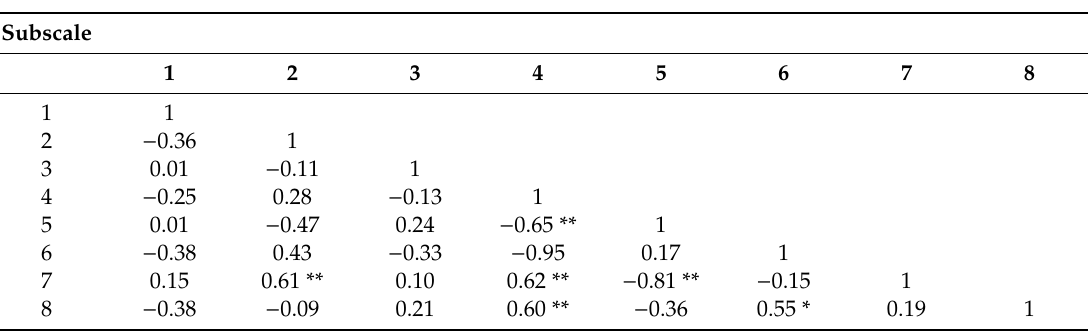
Table 5. PALMS subscale correlations.